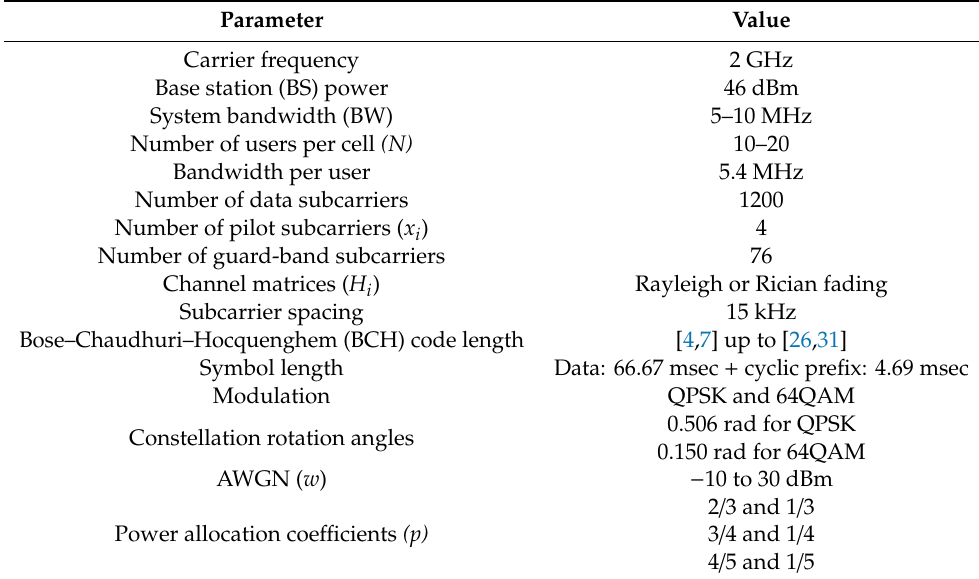
Table 1. NOMA system